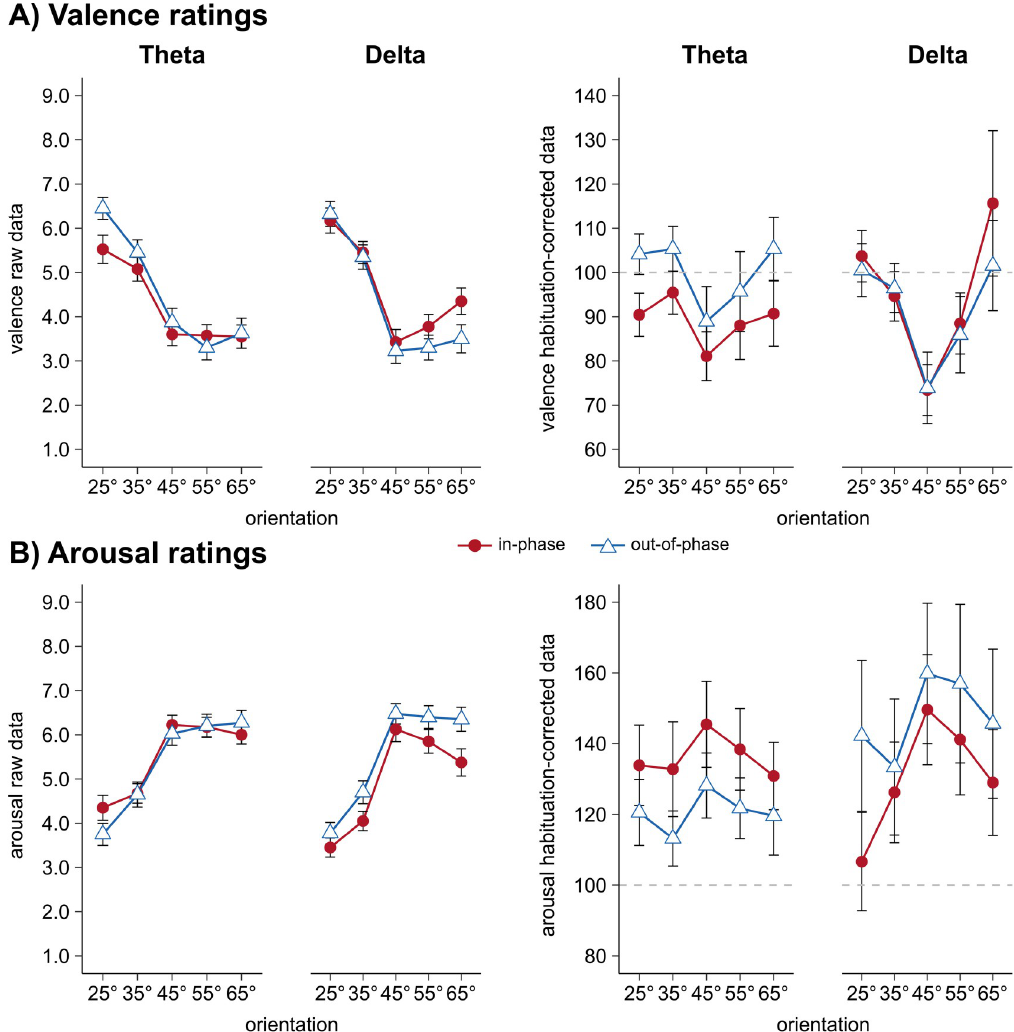
Fig 5. Raw and habituation-corrected valence and arousal ratings. Raw (left panel) as well as habituation-corrected (right panel) valence (A) and arousal (B) ratings separately for frequency (theta vs. delta) and synchronization condition (in-phase vs. out-of-phase). Valence ratings were collected as described in captions of Fig 3 and the Materials and Methods section (Dependent variables) . Each data point represents mean valence ratings for each CS orientation over participants per frequency and synchronization condition. Error bars show ± 1 SEM. Note that habituation-corrected values are depicted for better visualization of the fear generalization pattern. However, the statistics in the result section are based on the raw data. S3 and S4 Figs show discrimination indices (CS+ minus the average of all CS-) and estimation statistics for z-transformed valence and arousal ratings, respectively. For each frequency band (theta vs. delta) the discrimination index of in-phase and out-of-phase was